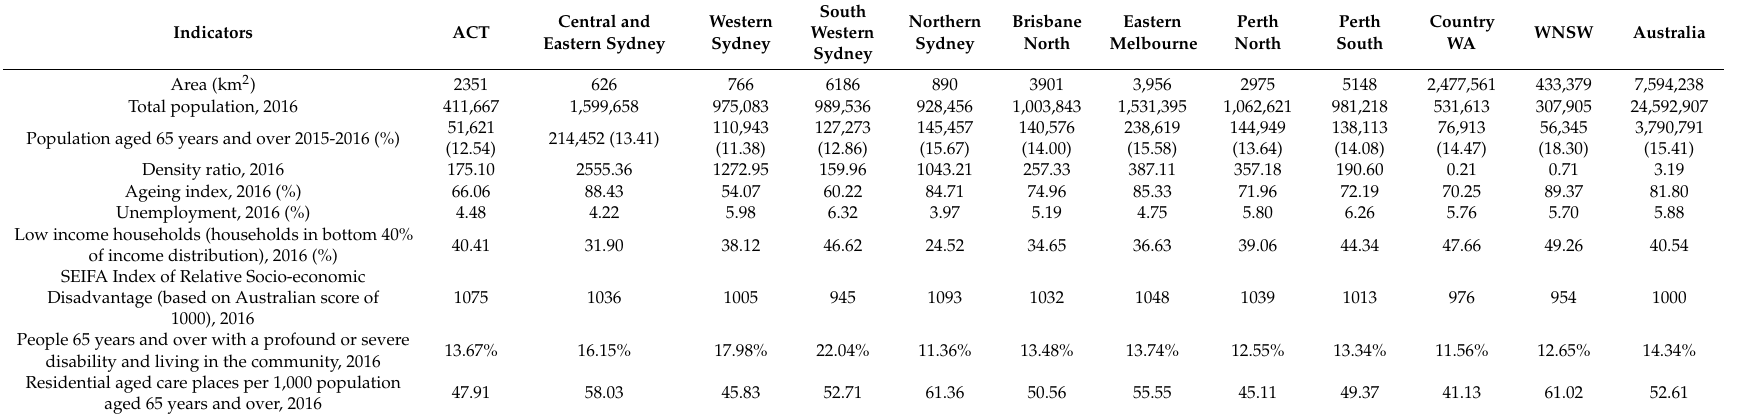
Table 1. Key demographic and socioeconomic factors in study